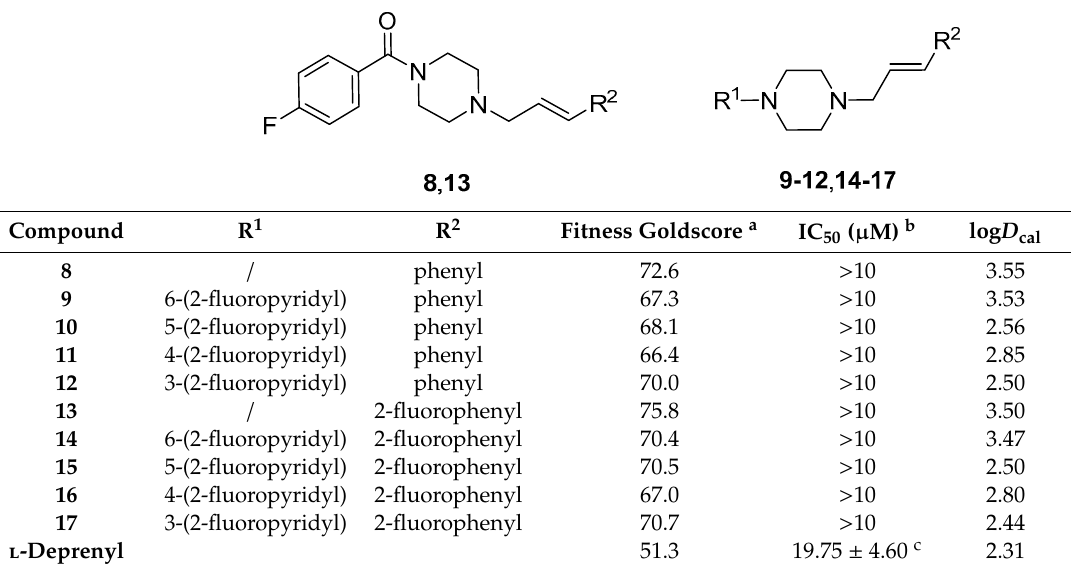
Table 1. Fitness goldscore, MAO-B binding affinities (IC 50 in µM) and calculated log D 7.4 of the synthesized compounds 8 – 17 .